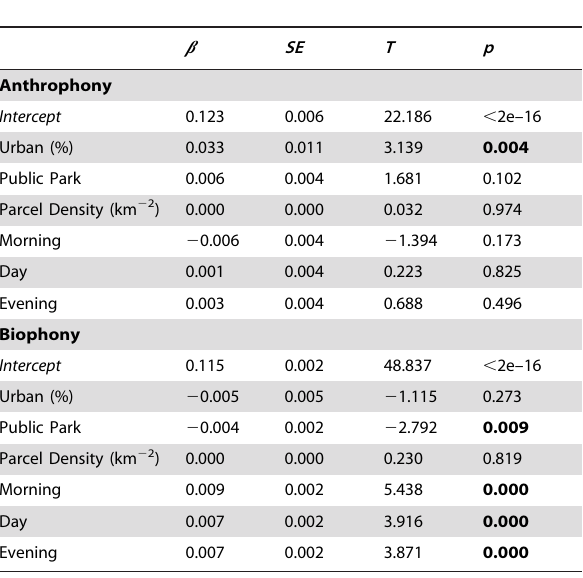
Table 2. Regression models for fixed effects of spatial and temporal factors on relative power of anthrophony and